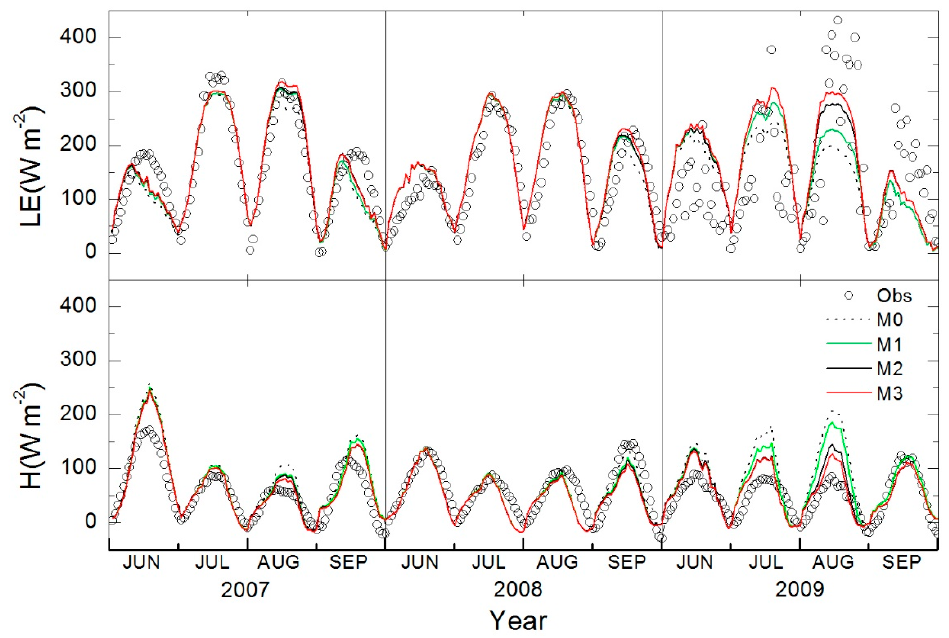
Figure 7. Comparison of simulated and observed values of diurnal variation for monthly averaged latent and sensible heat fluxes from June to September among different optimization schemes during 2007–2009.